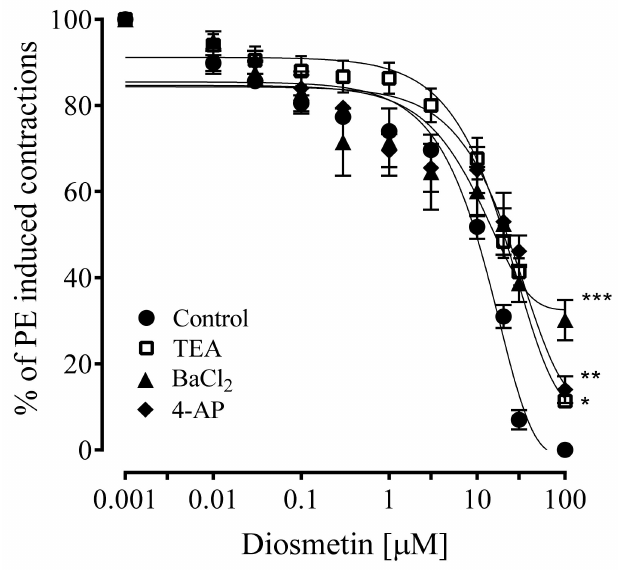
Figure 6. The response of diosmetin to phenylephrine (1 µ M) in the control and in the aortic rings of rats that were pretreated with tetraethylammonium (TEA; 5 mM), barium chloride (BaCl 2 ; 30 µ M) and 4-aminopyridine (4-AP; 1 mM). Significant differences vs. the control ( n = 6): * p < 0.05; ** p < 0.01; *** p <